Question: Looking at the figure, what chart type is it?
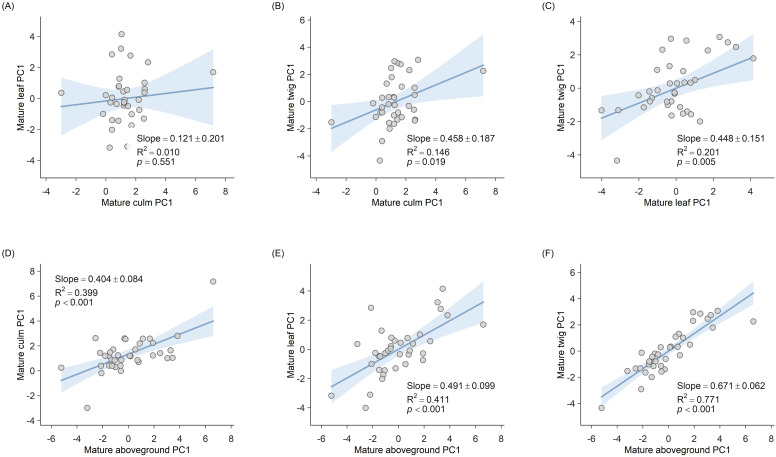
Answer: line